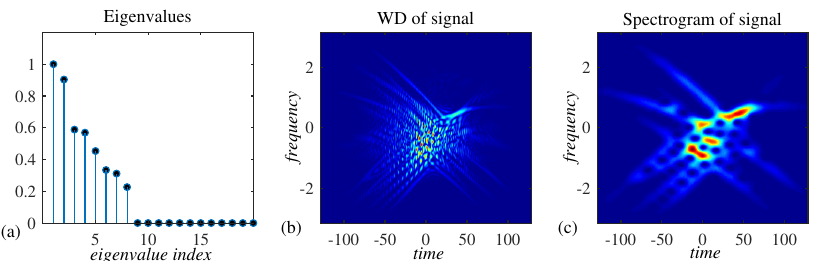
Figure 6. ( a ) Eigenvalues of autocorrelation matrix R , ( b ) Wigner distribution of the signal from Example 2, and ( c ) spectrogram of the signal from Example 2. Signal consists of P = 8 non-stationary components. The signal is embedded in an intensive complex, Gaussian, zero-mean noise with σ ε = 1. The number of channels is C = 128. The largest eight eigenvalues correspond to signal